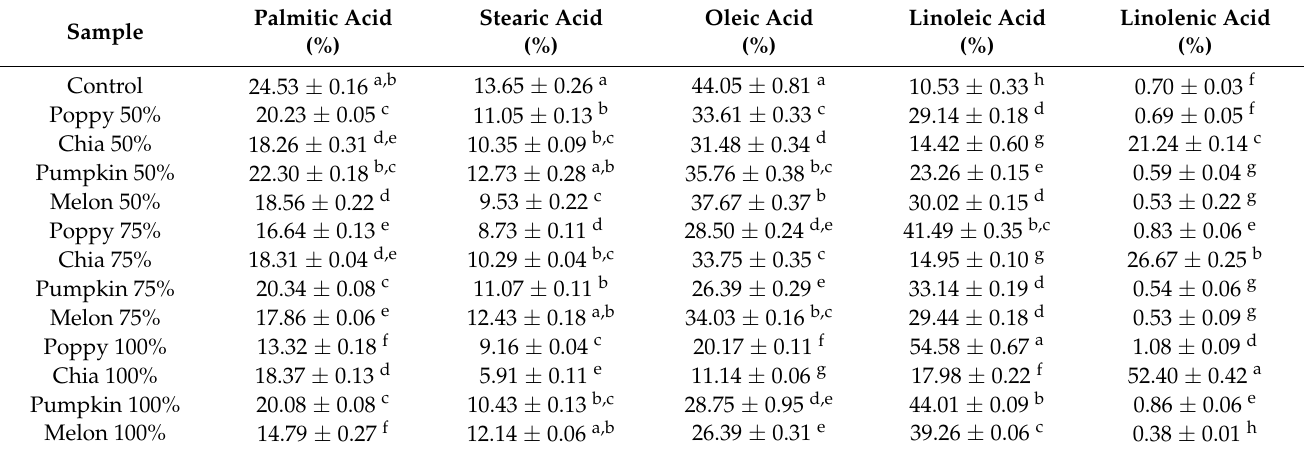
Table 6. Fatty acid composition of the different reformulated